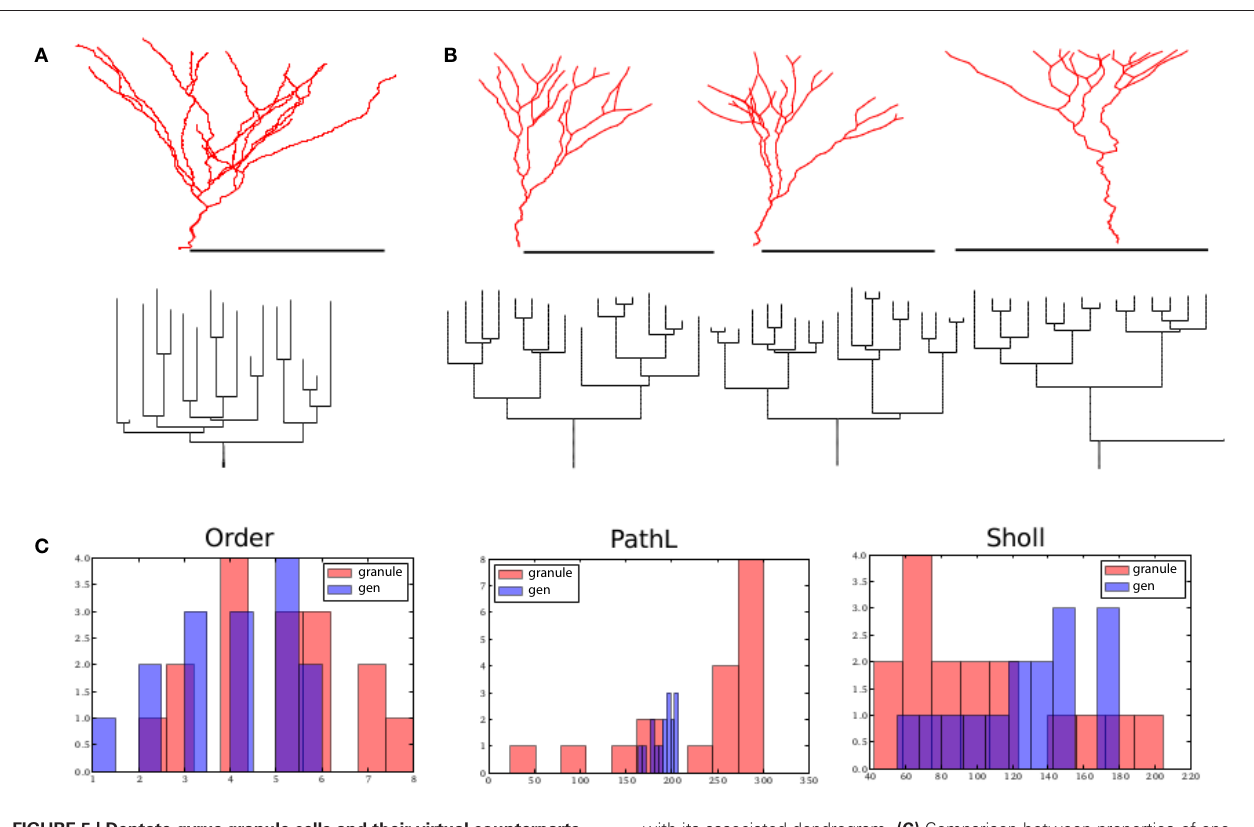
FIGURE 5 | Dentate gyrus granule cells and their virtual counterparts. (A) Exemplar morphology from Vuksic et al. (2008) with its dendrogram. (B) Three morphologies generated from one parameter configuration each